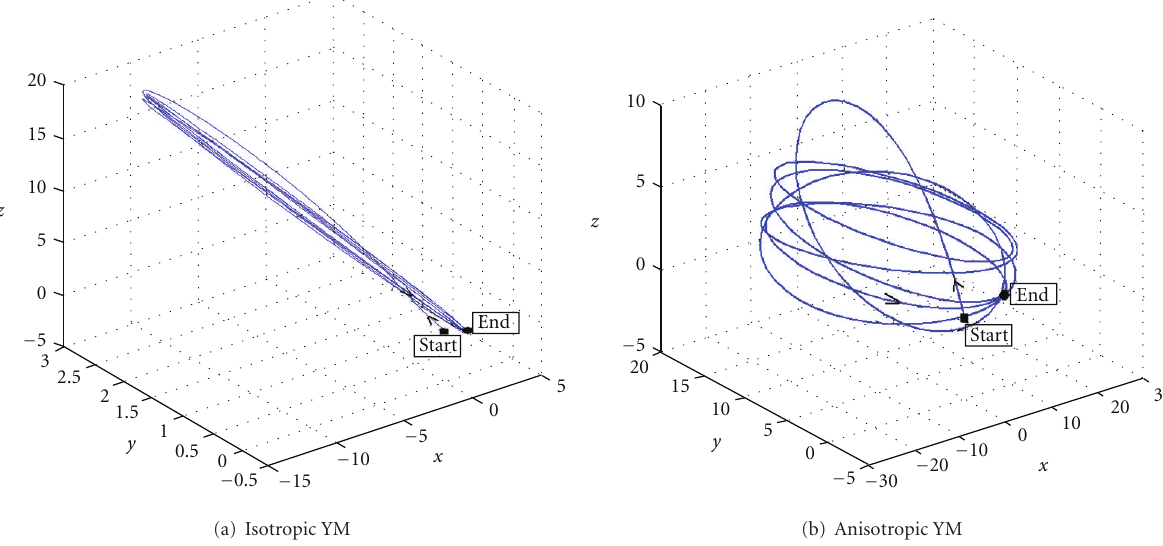
Figure 13: Predicted trajectories of monitored node A over 6 breathing cycles with (a) isotropic and (b) anisotropic YM.